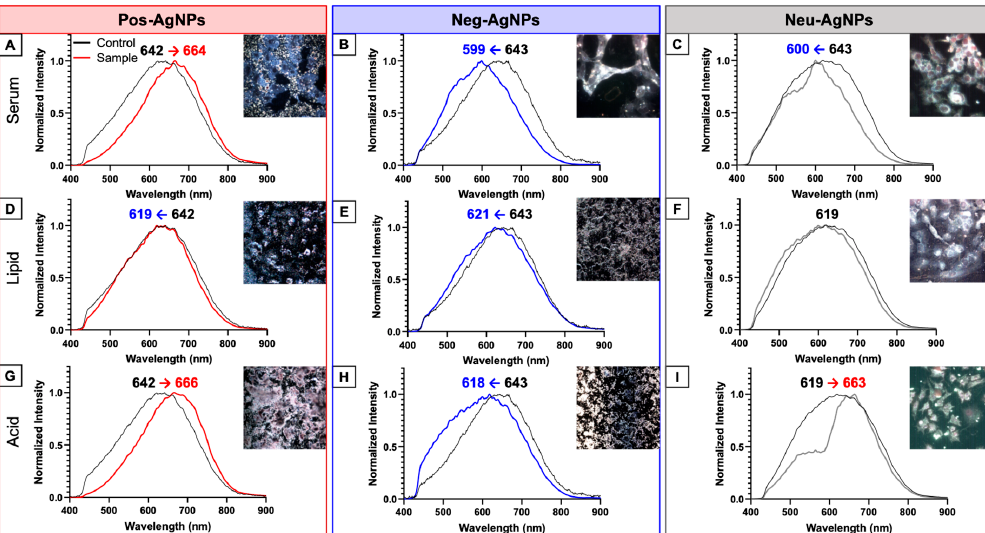
Figure 3. Enhanced darkfield and hyperspectral imaging of AgNPs subjected to incubation scenarios for 24 h and AgNP-exposed HepG2 cells for an additional 24 h. ( A ) Pos–AgNPs, ( B ) Neg–AgNPs, and ( C ) Neu–AgNPs incubated in serum. ( D ) Pos–AgNPs, ( E ) Neg–AgNPs, and ( F ) Neu–AgNPs incubated in lipids. ( G ) Pos–AgNPs, ( H ) Neg–AgNPs, and ( I ) Neu–AgNPs incubated in acid. The number noted above each spectrum indicates pre-incubated λ max (black font) and post-incubated λ max (blue or red font).